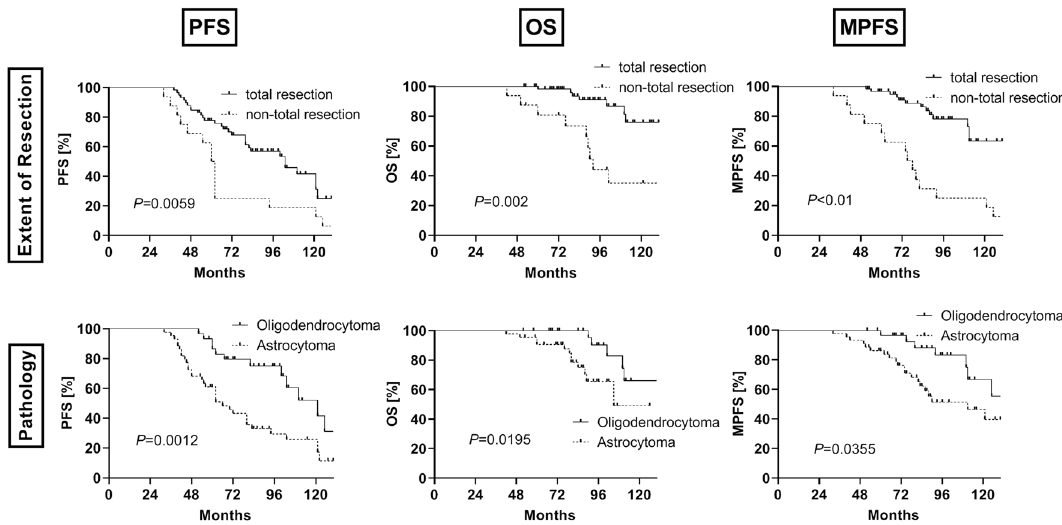
Figure 1. Kaplan–Meier curves showed the PFS (first column), OS (second column) and MPFS (third column) associated with the factors of extent of resection (first row) and tumor pathology (second